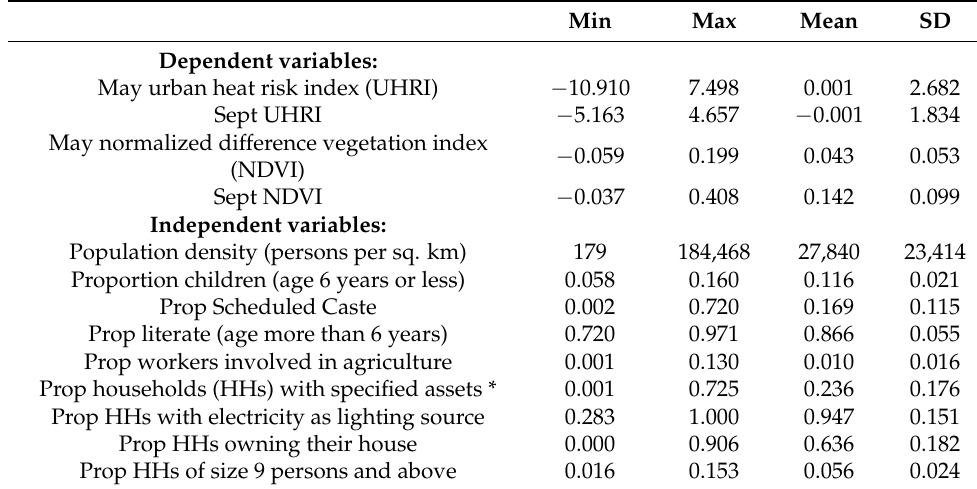
Table 1. Summary statistics for variables analyzed ( n = 281